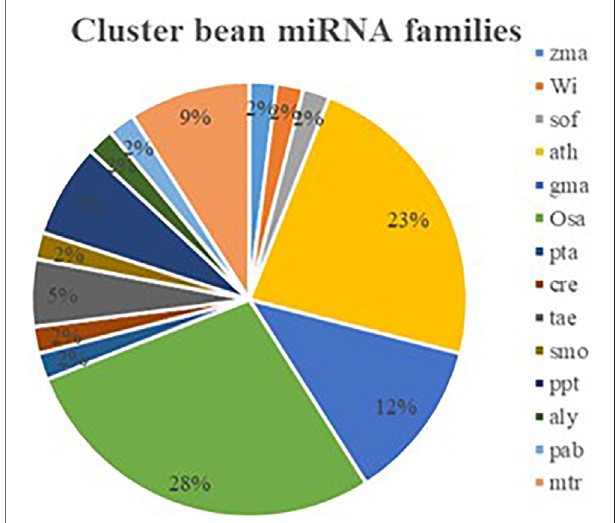
FIGURE 2 | Identi fi ed miRNA families of cluster bean which have homologues in other plant species (ath- Arabidopsis thaliana , osa- Oryza sativa , gma- Glycine max , mtr- Medicago truncatula , zma- Zea mays , vvi- Vitis vinifera , sof- Saccharum of fi cinarum , pab- Picea abies , aly-